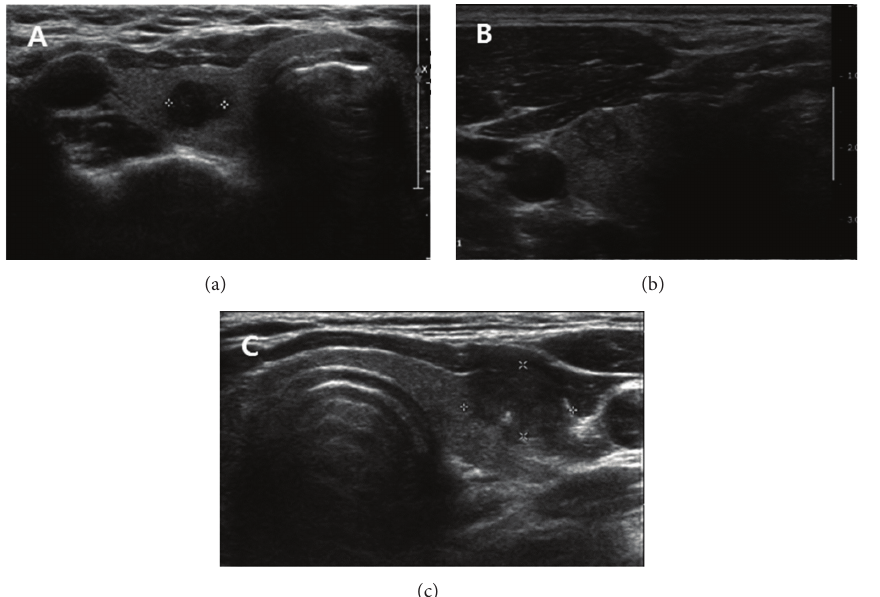
Figure 1: Grouping of thyroid tumor according to ultrasonographic findings. (a) Group 1: the tumor is completely enveloped by thyroid parenchyma, (b) Group 2: the tumor is attached to the thyroid capsule without definite destruction of the capsule, (c) Group 3: the tumor destroys the thyroid capsule and the capsule shadow is disconnected.